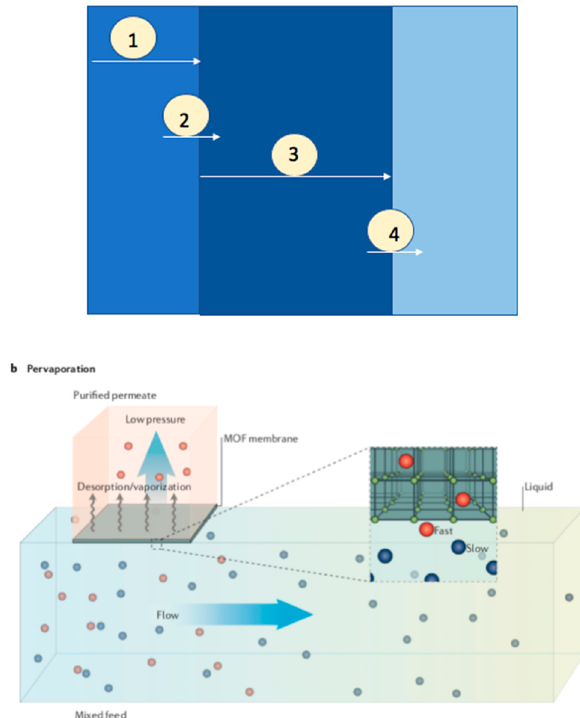
Figure 10. Schematic illustrations for pervaporation method; Reproduced with permission from [18].